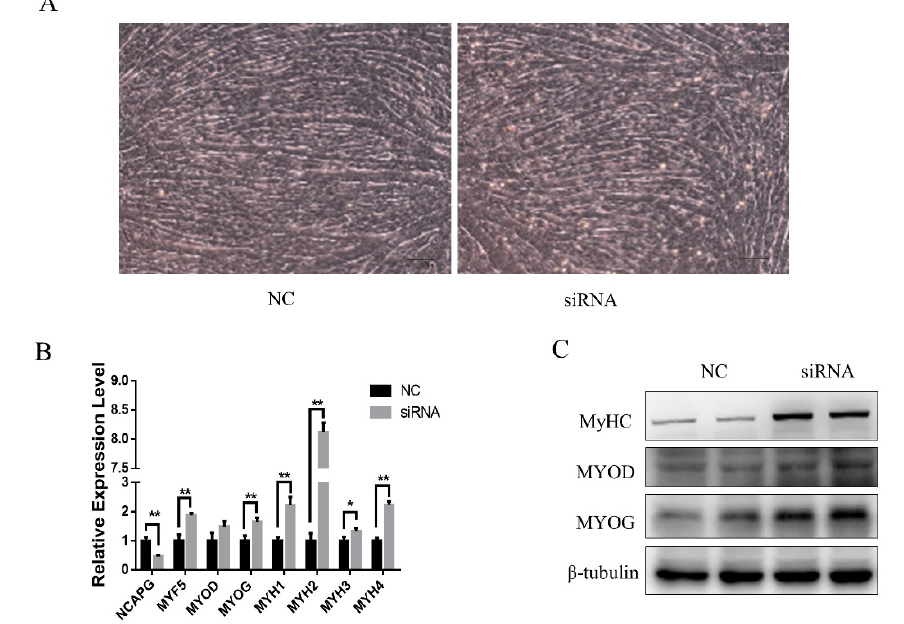
Figure 5. Myogenic gene expression was upregulated after 1.5 d of differentiation in NCAPG-silenced myoblast. ( A ) The cell morphology of NCAPG -silenced myoblasts on day 1.5 of differentiation. Scale bar = 100 µm. ( B ) Transcript levels of muscle-specific genes on day 1.5 of differentiation. The results are presented as the mean ± the SEM from at least three independent experiments: * p < 0.05, ** p < 0.01. ( C ) Western blot evaluating the protein levels of MYOD, MYOG, and MHCs in myoblasts on day 1.5 of differentiation.